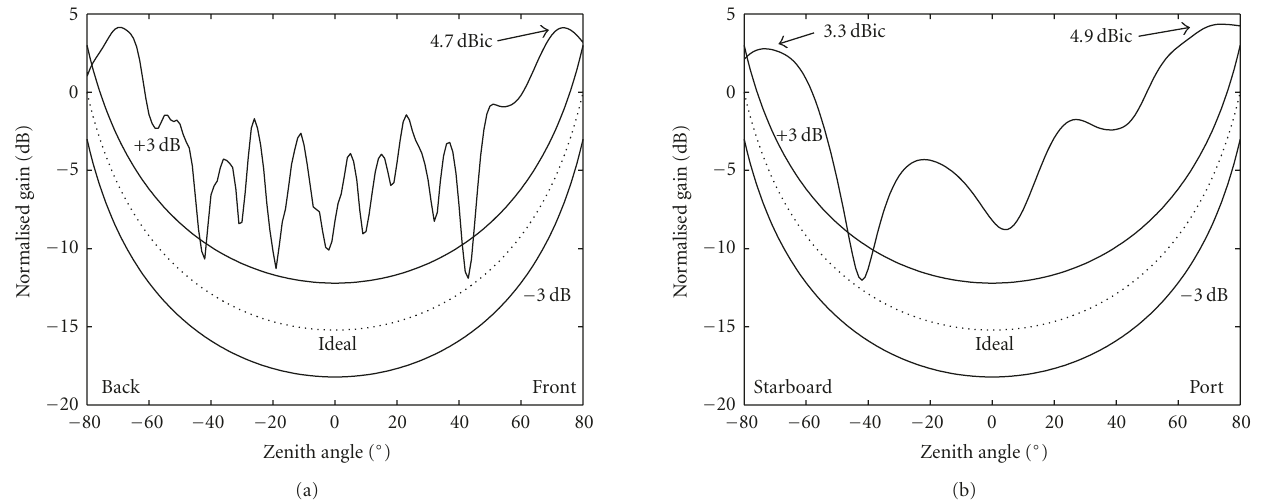
Figure 10: Principal plane radiation patterns of the single turn helical antenna on the gondola; (a) azimuth angle 0 ◦ { along the gondola } , (b) azimuth angle 90 ◦ { across the gondola } , normalised to minimum value of zenith 80 ◦ gain, from FEKO.